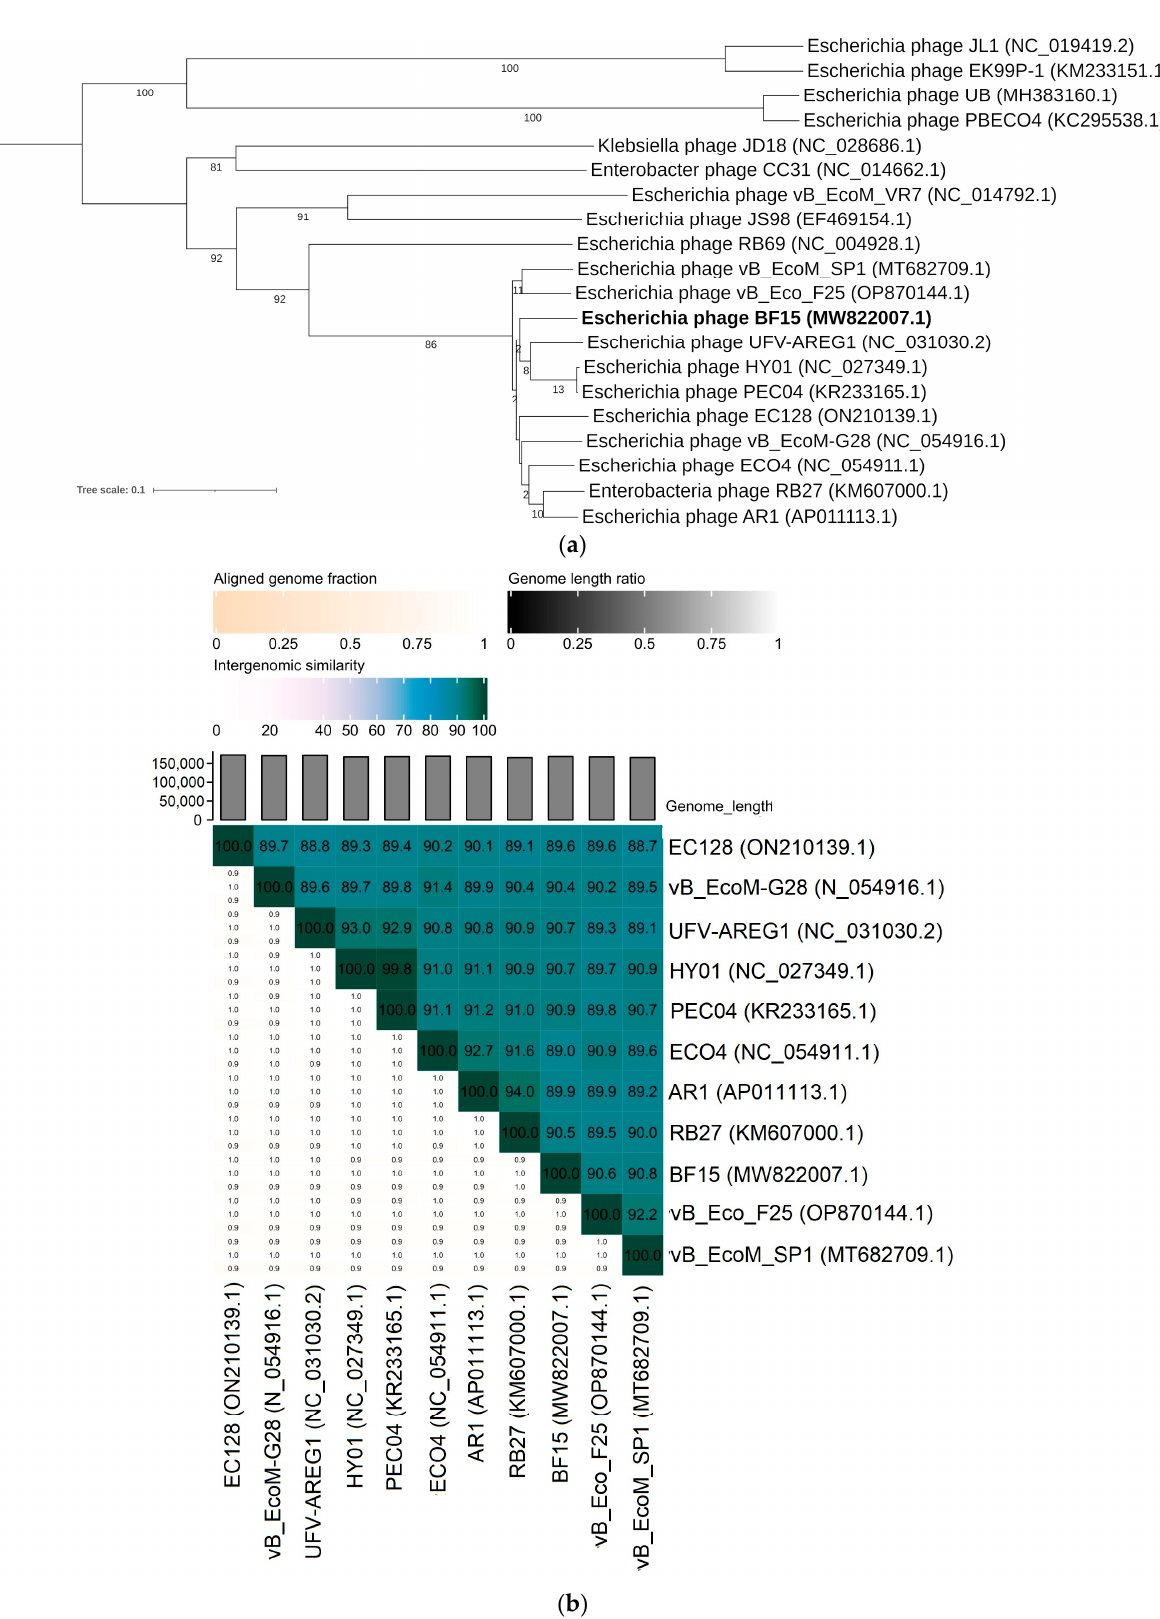
structure (green arrows), DNA packaging (orange arrows), host lysis (red arrows), phage DNA replica- tion and modification (blue arrows), and additional functions (purple arrows). Grey arrows represent ORFs of unknown